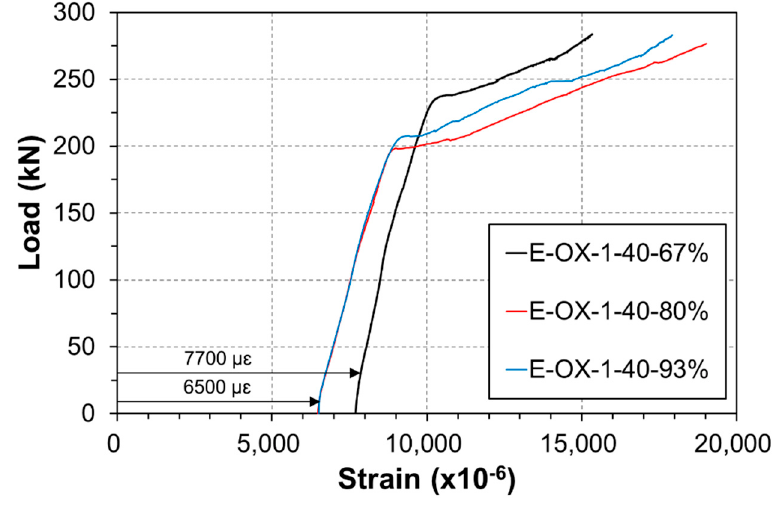
Figure 15. Load-strain relationship at CFRP (Bond length).